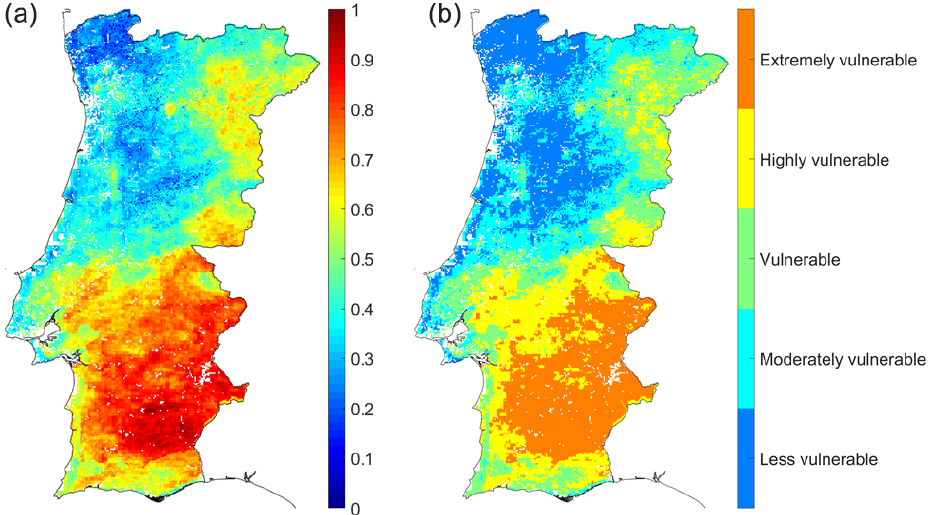
Figure 7. (a) Two initial PCs resulting from the application of the PCA to the three components presented in Fig. 4, and loading factors for each component. (b) Classes of vulnerability of the main crops to drought, derived from the map on the